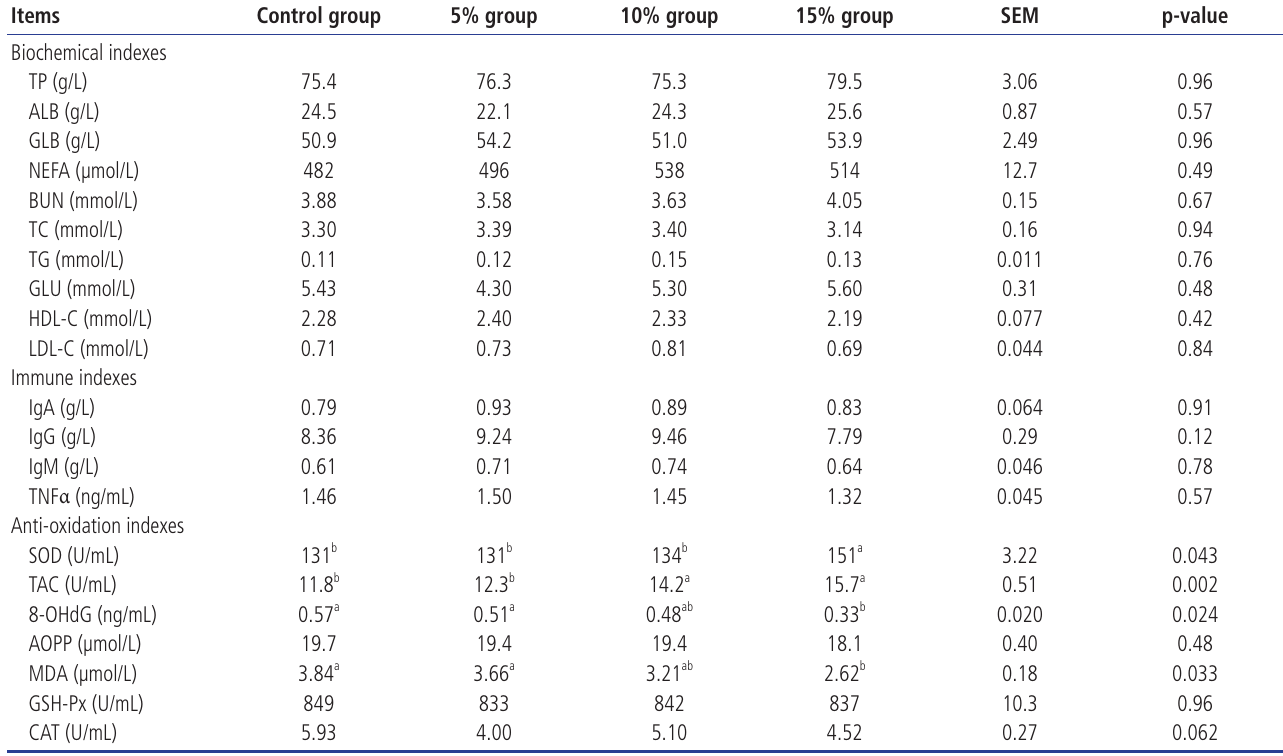
Table 4. Effect of Broussonetia papyrifera silage levels on blood biochemical parameters, immune indexes and anti-oxidant indexes of black Angus